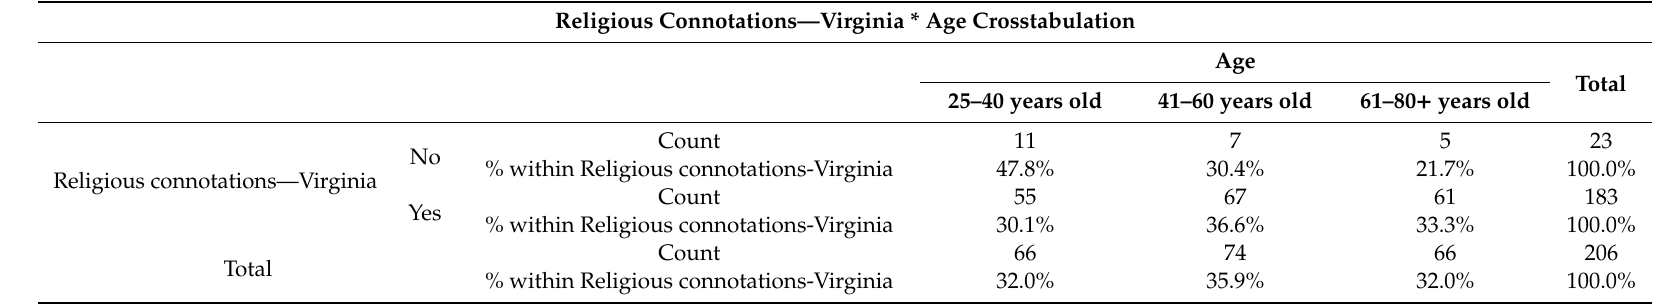
Table 4. Religious connotations in terms of age for the name Virginia in the metropolitan district of Leeds.